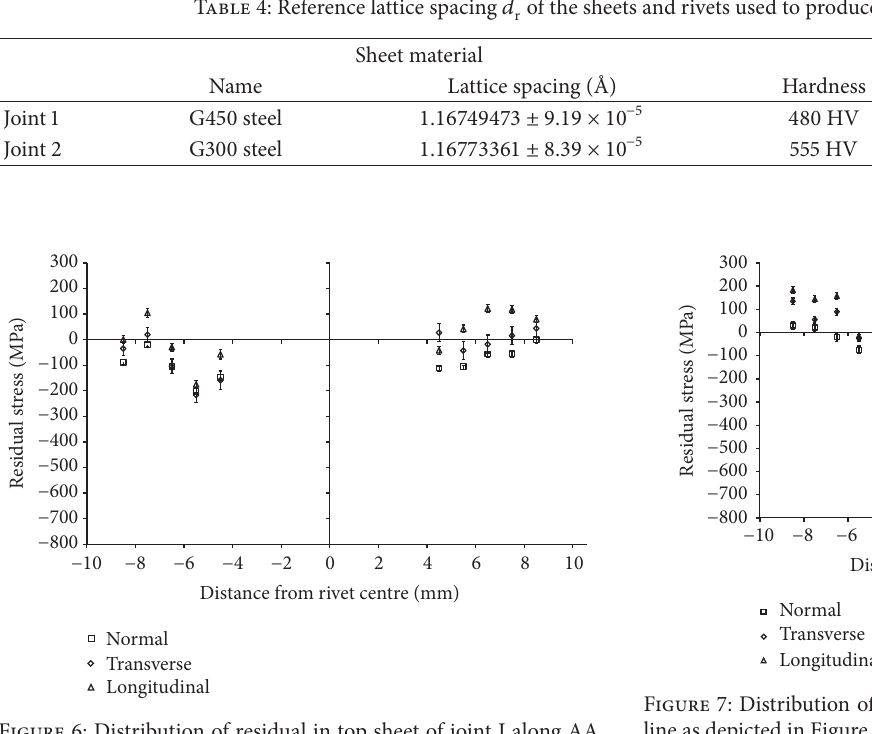
Figure 6: Distribution of residual in top sheet of joint I along AA line as depicted in Figure 4(a).